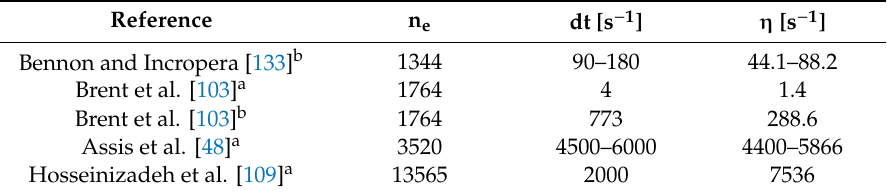
Table 4. Performance indicators of numerical studies of phase